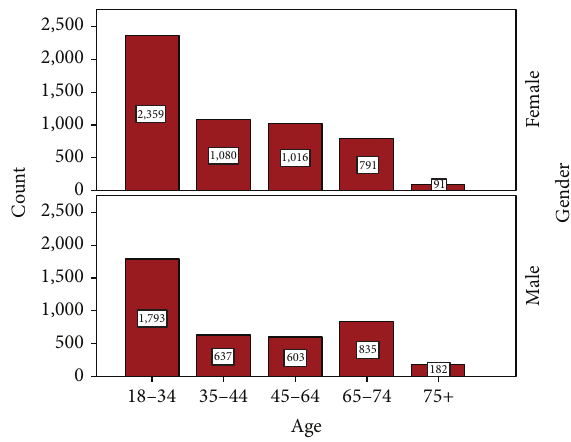
Figure 1: Patients participation according to sex and age group.